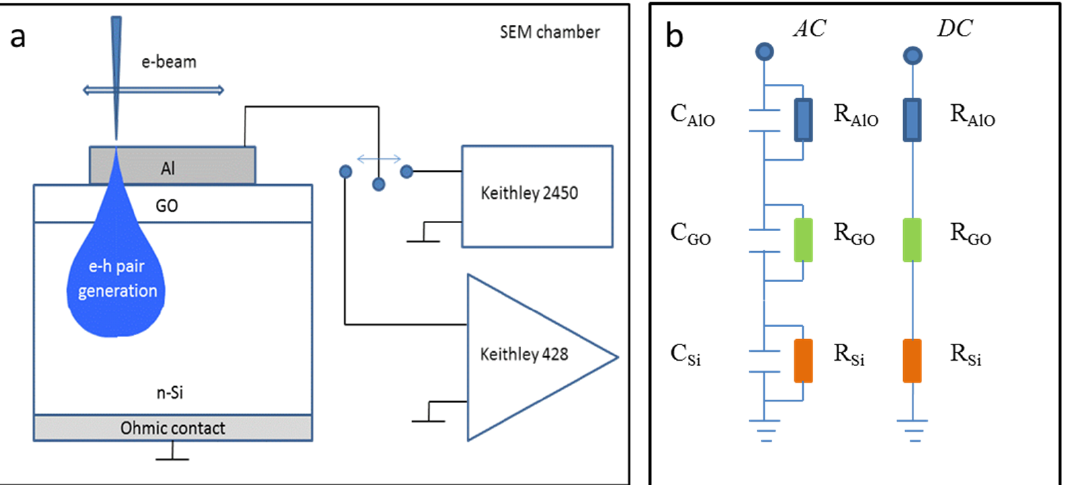
Figure 1. ( a ) Schematic presentation of the Al/GO/n-Si MIS structure and the experimental setup for current–voltage measurements using Keithley 2450 Source Meter and EBIC characterization using Keithley 428 Current Amplifier; ( b ) equivalent circuits of the Al/GO/n-Si MIS structure under AC and DC measurements, respectively.